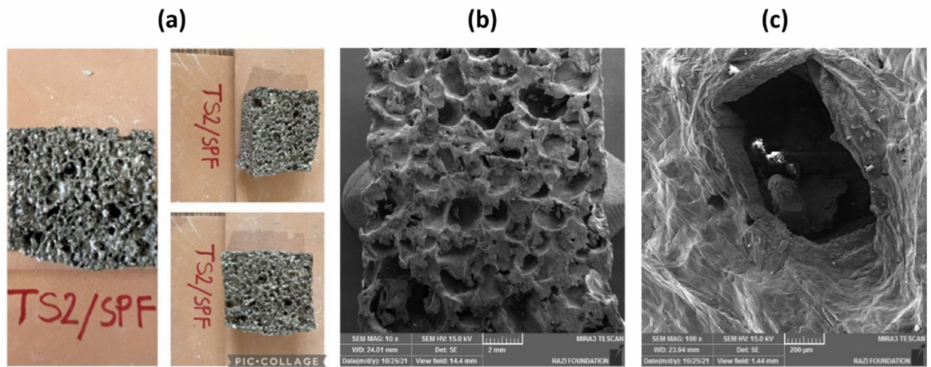
Figure 8. ( a ) Macroscopic images of produced foam and its SEM micrographs with a magnification of ( b ) 10 × and ( c ) 100 ×